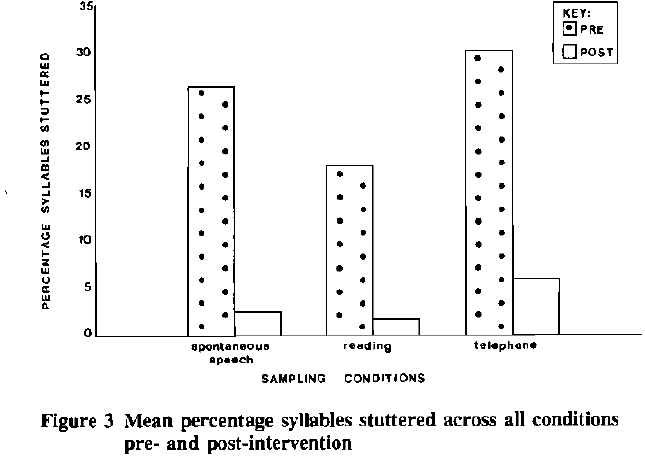
Figure 3 Mean percentage syllables stuttered across all conditions pre- and post-intervention A minimal increase in SPM was noted from pre- to post-intervention speech sampling (See Figure 4). The post-intervention rate of ap- proximately 140 SPM is slow compared to normals but may be ac- counted for in terms of the stage of therapy attained i.e. 140 SPM stutter free speech under volitional control.